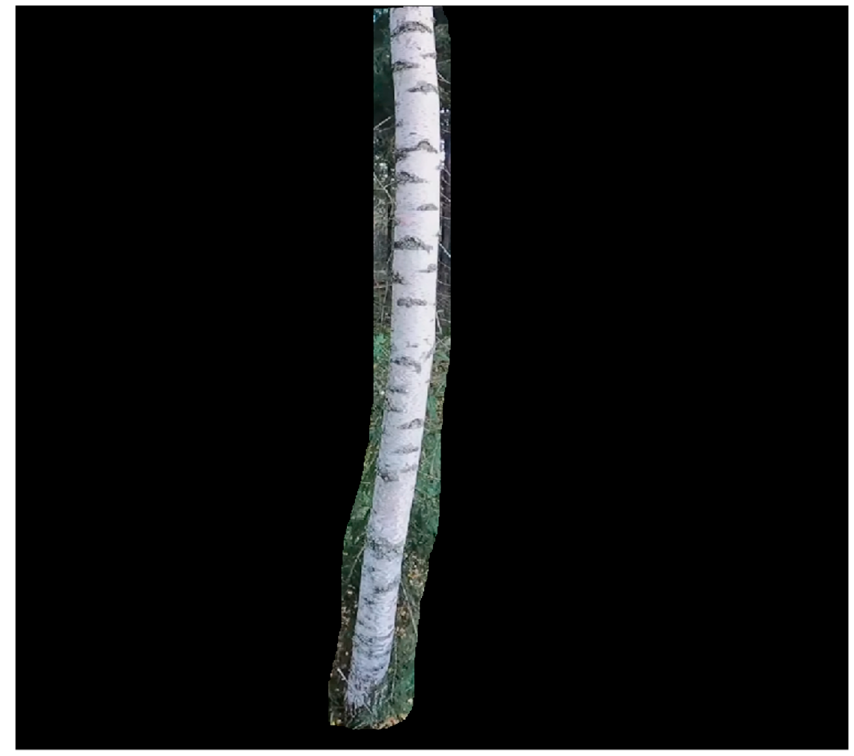
Figure 1. An example of an image from the general sample with a birch trunk.